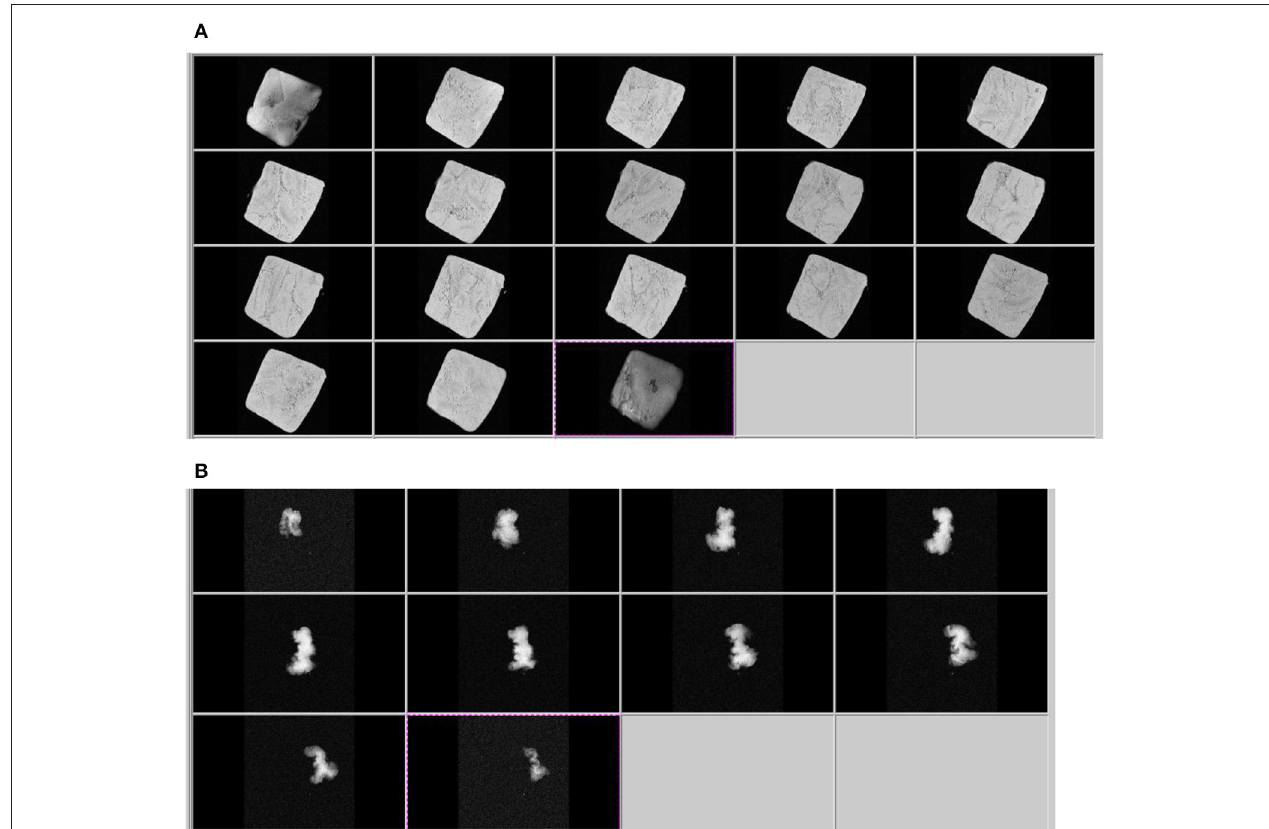
FIGURE 3 | Axial slices of T 2 weighted images of fresh pumpkin (A) and dried sample after 70min at 70 ◦ C (B) .